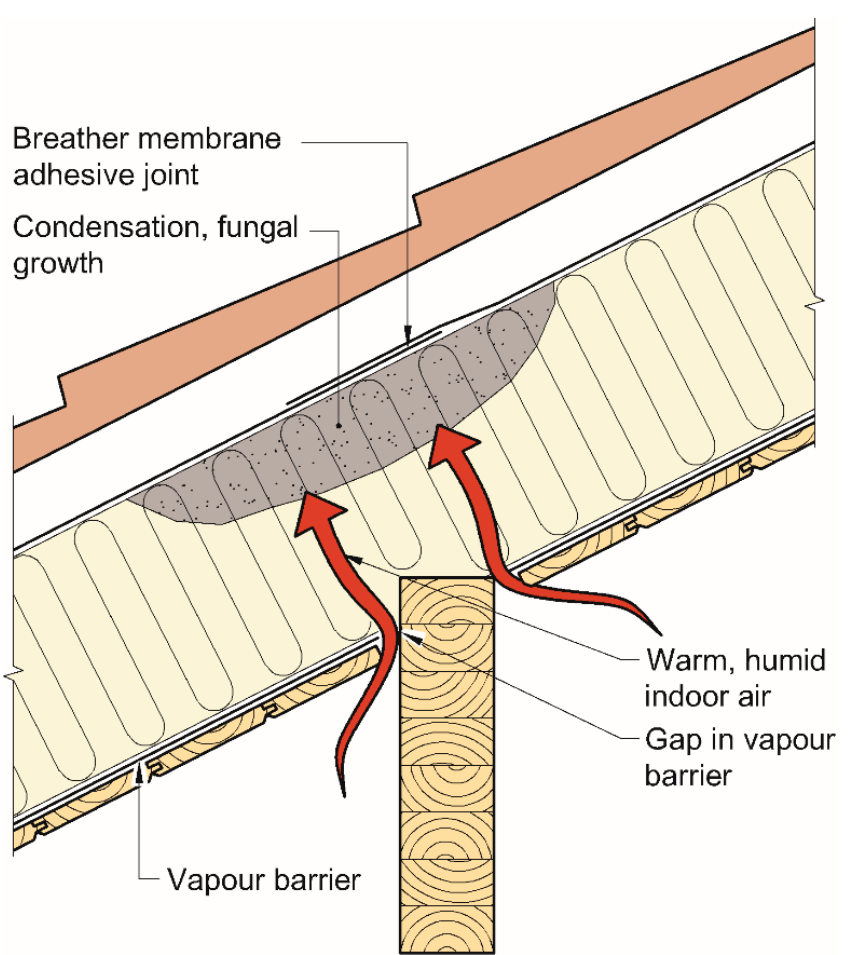
Figure 1. Accumulation of humidity causing condensation and risk of mould growth. Figure adapted from [21].